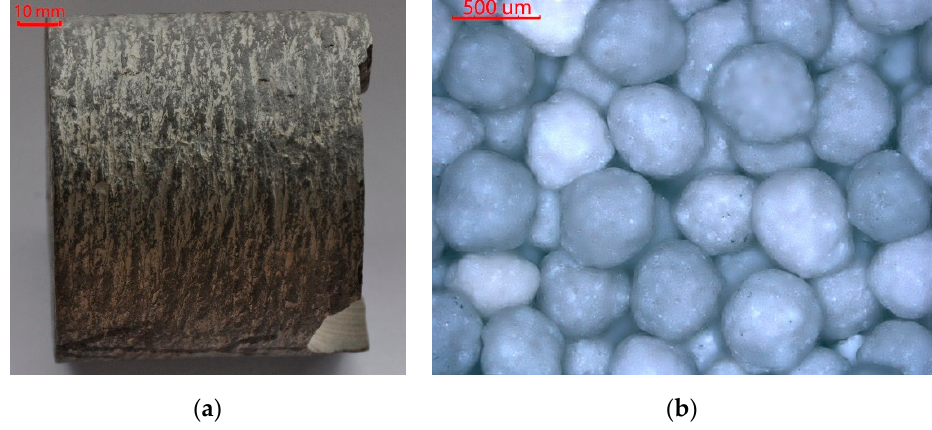
Figure 4. Materials used for testing: ( a ) Shale rock; ( b ) Proppant.